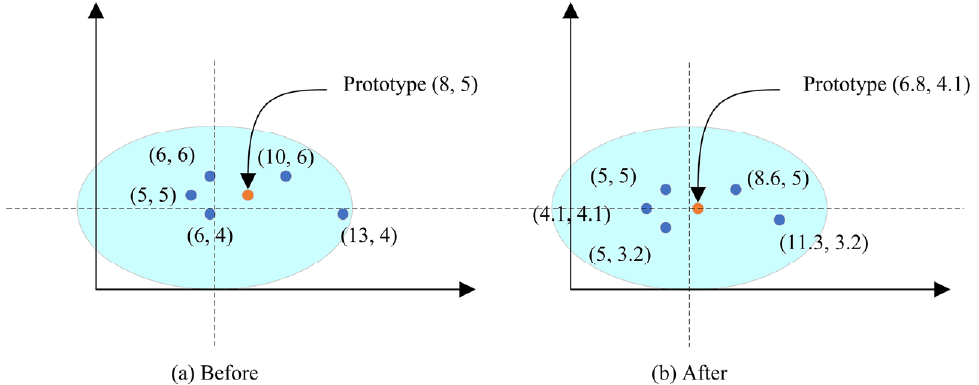
Figure 7. Take the 5-shot problem and 2-dimensional feature vector as an example. The left figure shows the prototype provided by average operation only, where there is a deviation on the prototype. In this example, simply assuming our γ is (0.9, 0.9) and β is ( − 0.4, − 0.4), feature vectors are dealt with the scale and shift vectors in front of averaging, and the right figure is achieved. It is obvious that the prototype of the right figure is much closer to the center than that of the left figure.